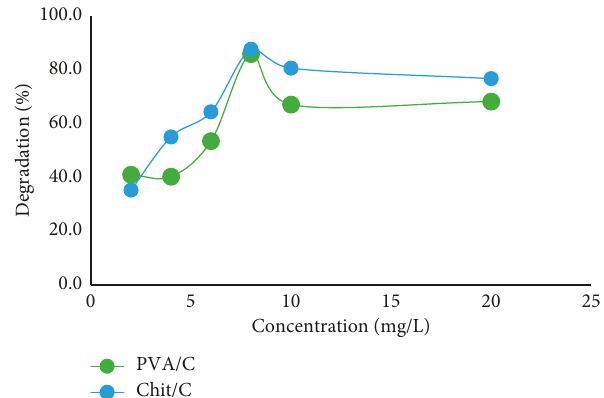
Figure 5: Percentage photodegradation as a function of pH. Figure